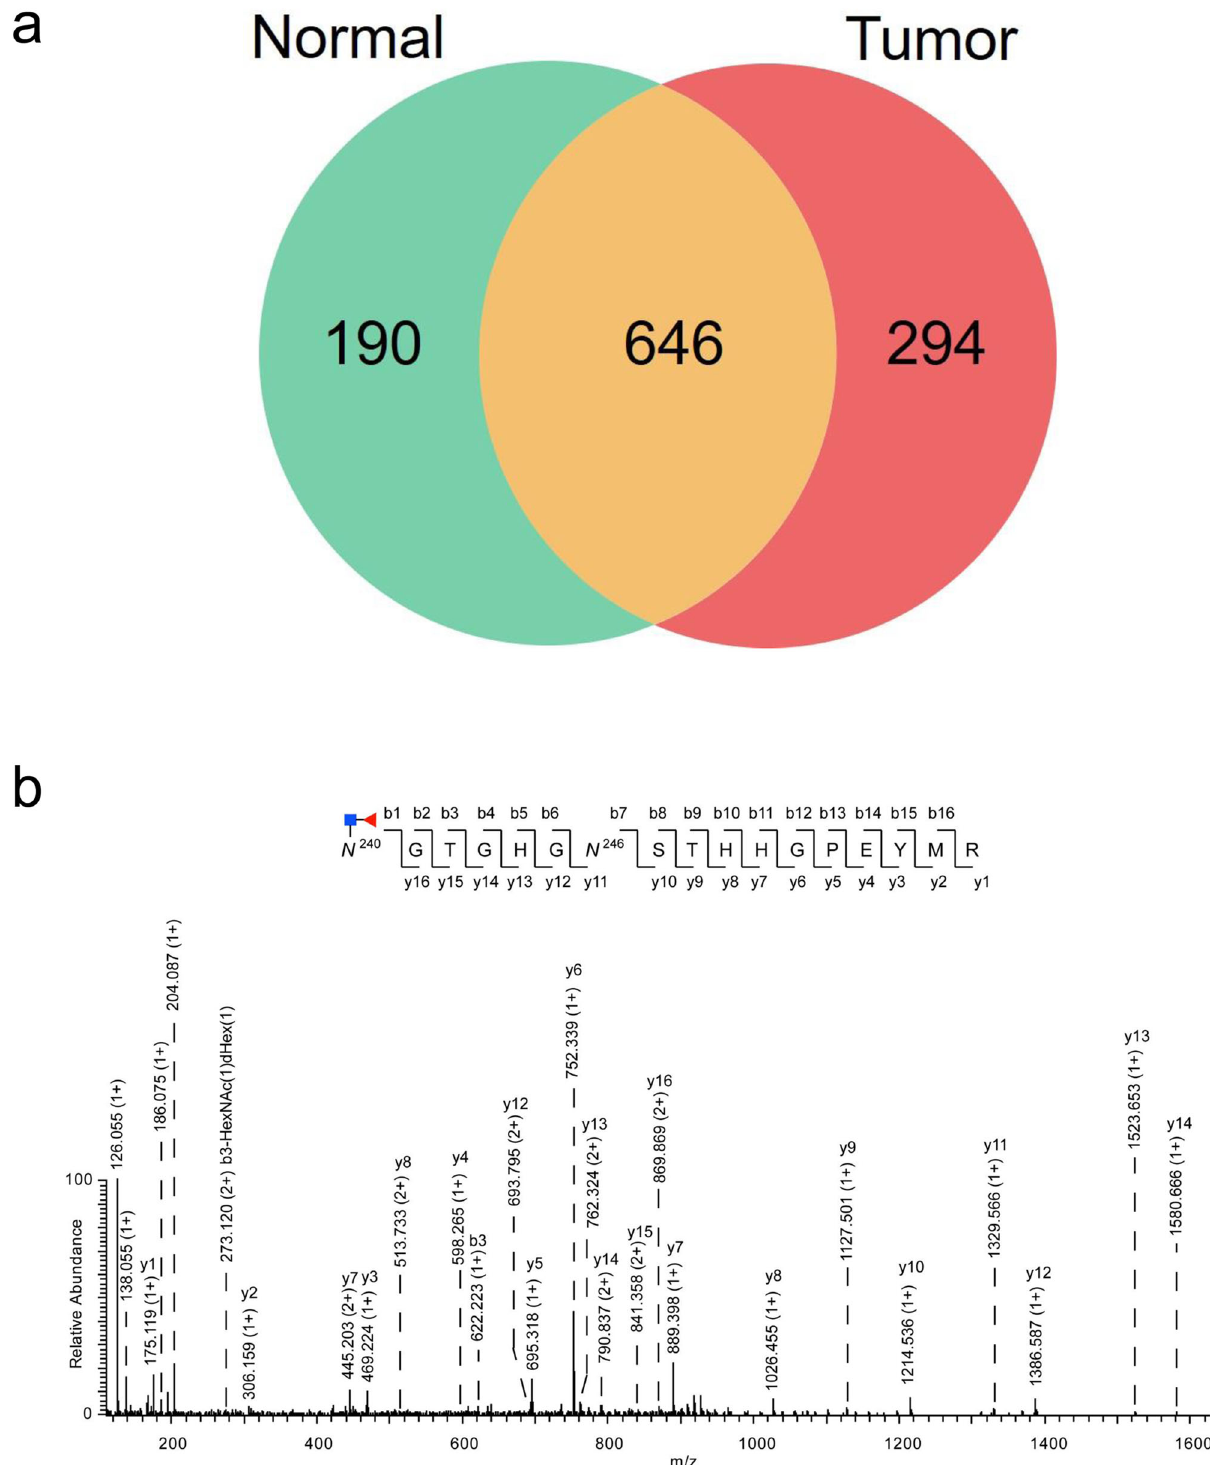
Fig. 3 Characterization of CF sites from human HCC tumor and normal tissues using the STAGE method. a Number of identi fi ed CF sites in tumor and normal liver tissues. b MS/MS spectrum of the CF glycopeptide, N 240 GTGHG N 246 STHHGPEYMR from hemopexin (UniProt ID: P02790). The site, N 240 , was modi fi ed by CF biantennary glycans, whereas the site, N 246 , was a glycosite that was modi fi ed by other glycans. Keys: b-HexNAc(1)dHex(1) represents a disaccharide, HexNAc(1)dHex(1), is lost from this b ion; y-HexNAc(1)dHex(1) represents a disaccharide, HexNAc(1)dHex(1), is lost from this y ion; b- HexNAc(1) represents a monosaccharide residue, HexNAc(1), is lost from this b ion; y-HexNAc(1) represents a monosaccharide residue, HexNAc(1), is lost from this y